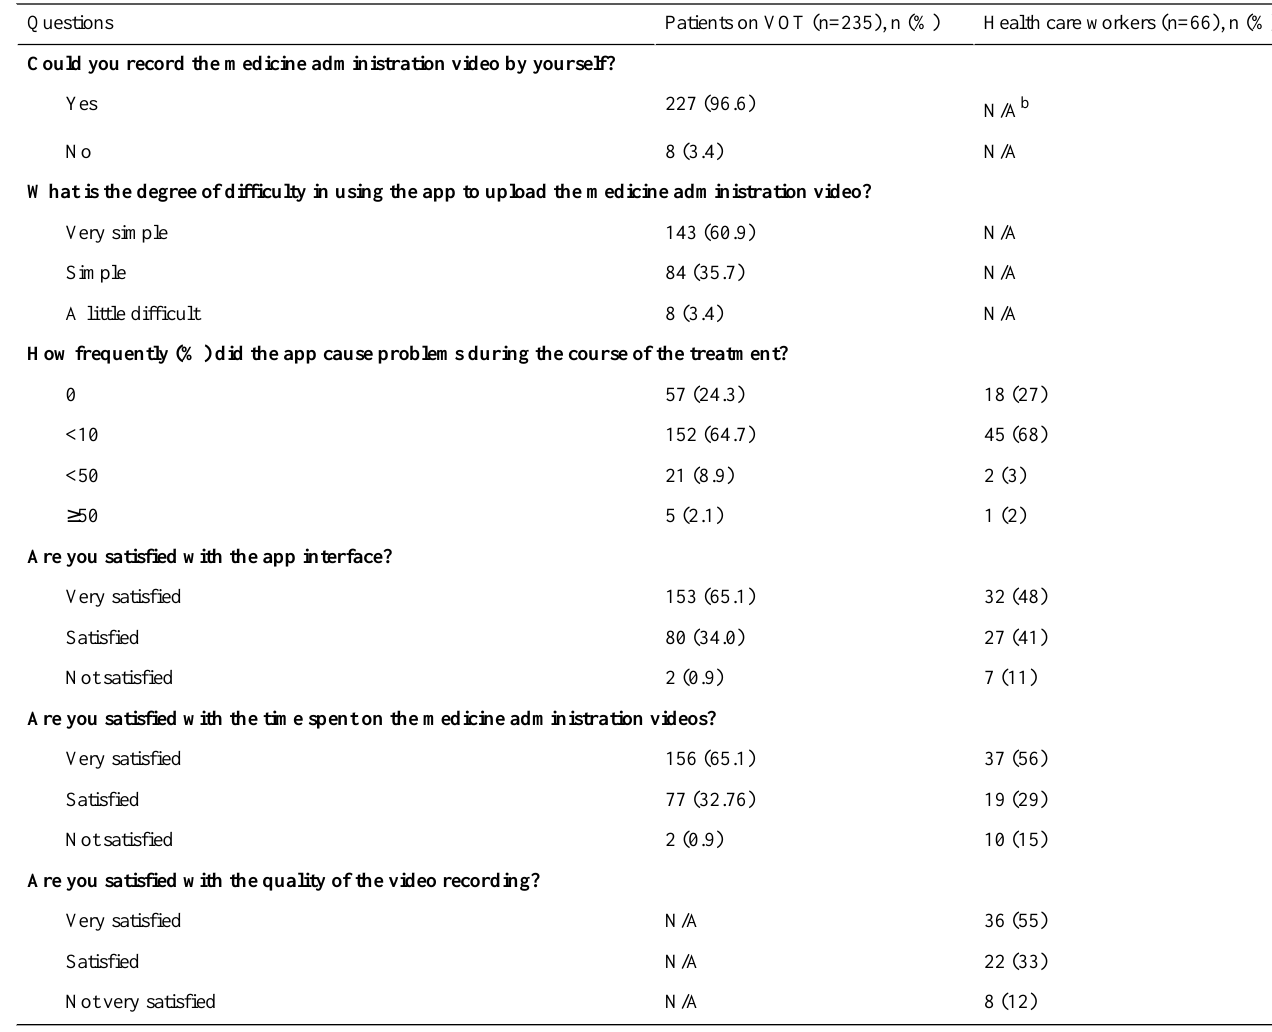
Table 6. Acceptance of the patients on VOT a and health care workers with the use of the